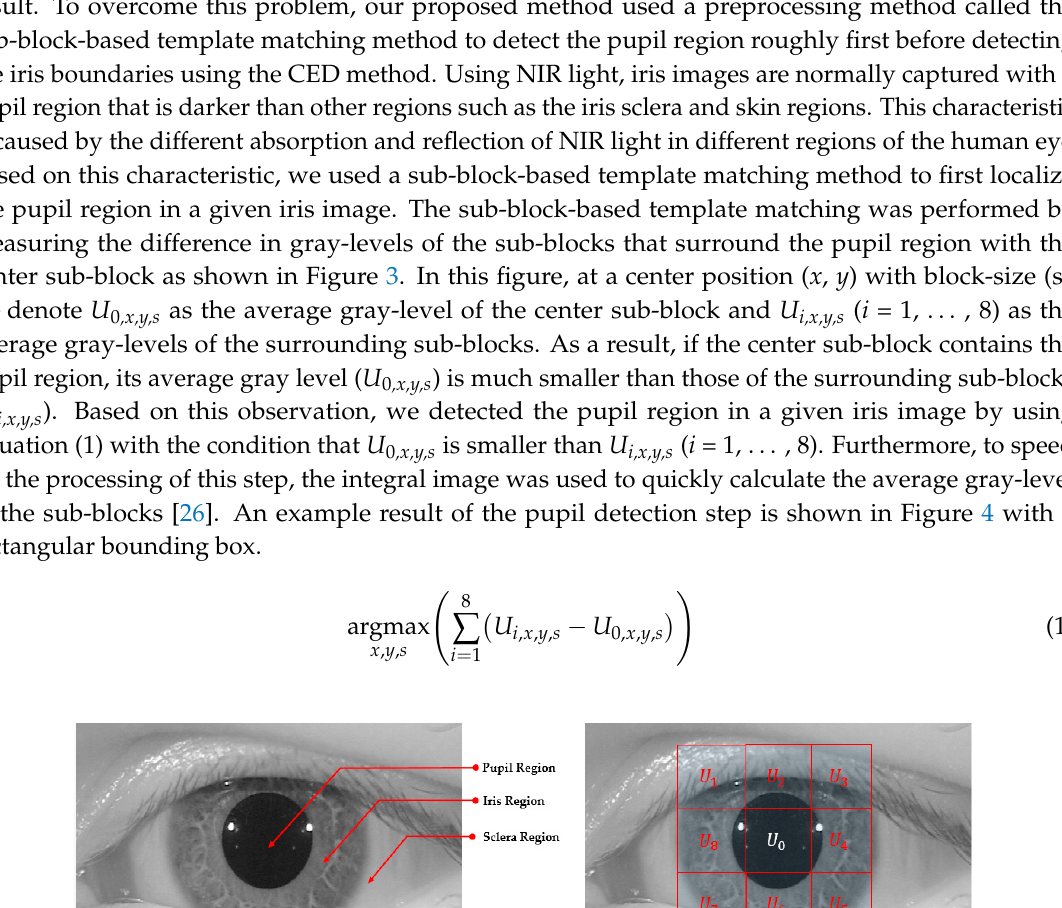
Figure 3. Block-based method for pupil region detection. ( a ) Pupil, iris, and sclera regions of eye image. ( b ) Example of 9 sub-blocks on pupil and iris